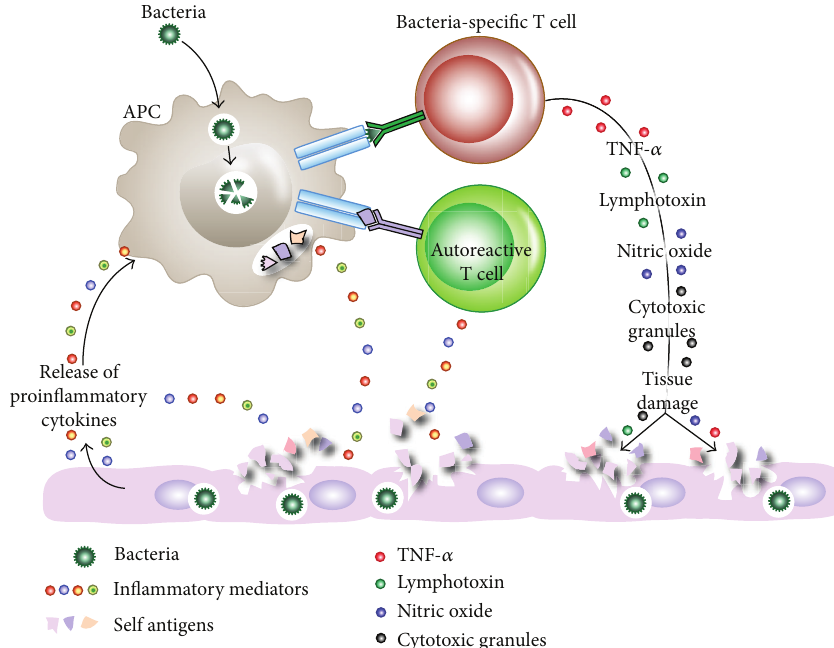
Figure 7: Microbial infection stimulates toll-like receptors (TLRs) and other pattern recognition receptors on antigen-presenting cells (APCs), leading to the production of proinflammatory mediators, which in turn can lead to tissue damage. The release of both tissue antigens and bacterial antigens results in bacterial-specific T cells and autoreactive T cells in the process called bystander activation, which contributes to autoimmunity.